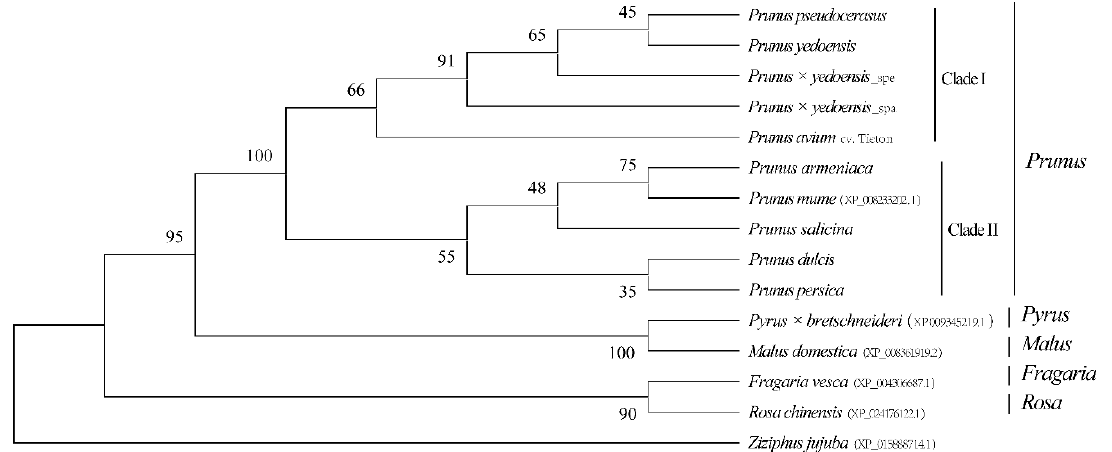
Figure 6. Phylogenetic tree based on the amino acid sequences of CENH3. NJ phylogenetic trees were reconstructed using MEGAX with the Jones–Taylor–Thornton (JTT) evolutionary model. CENH3 from Ziziphus jujuba was used as an outgroup. The numbers on the nodes correspond to bootstrap values based on 1000 tests. Only values higher than 30% are shown.